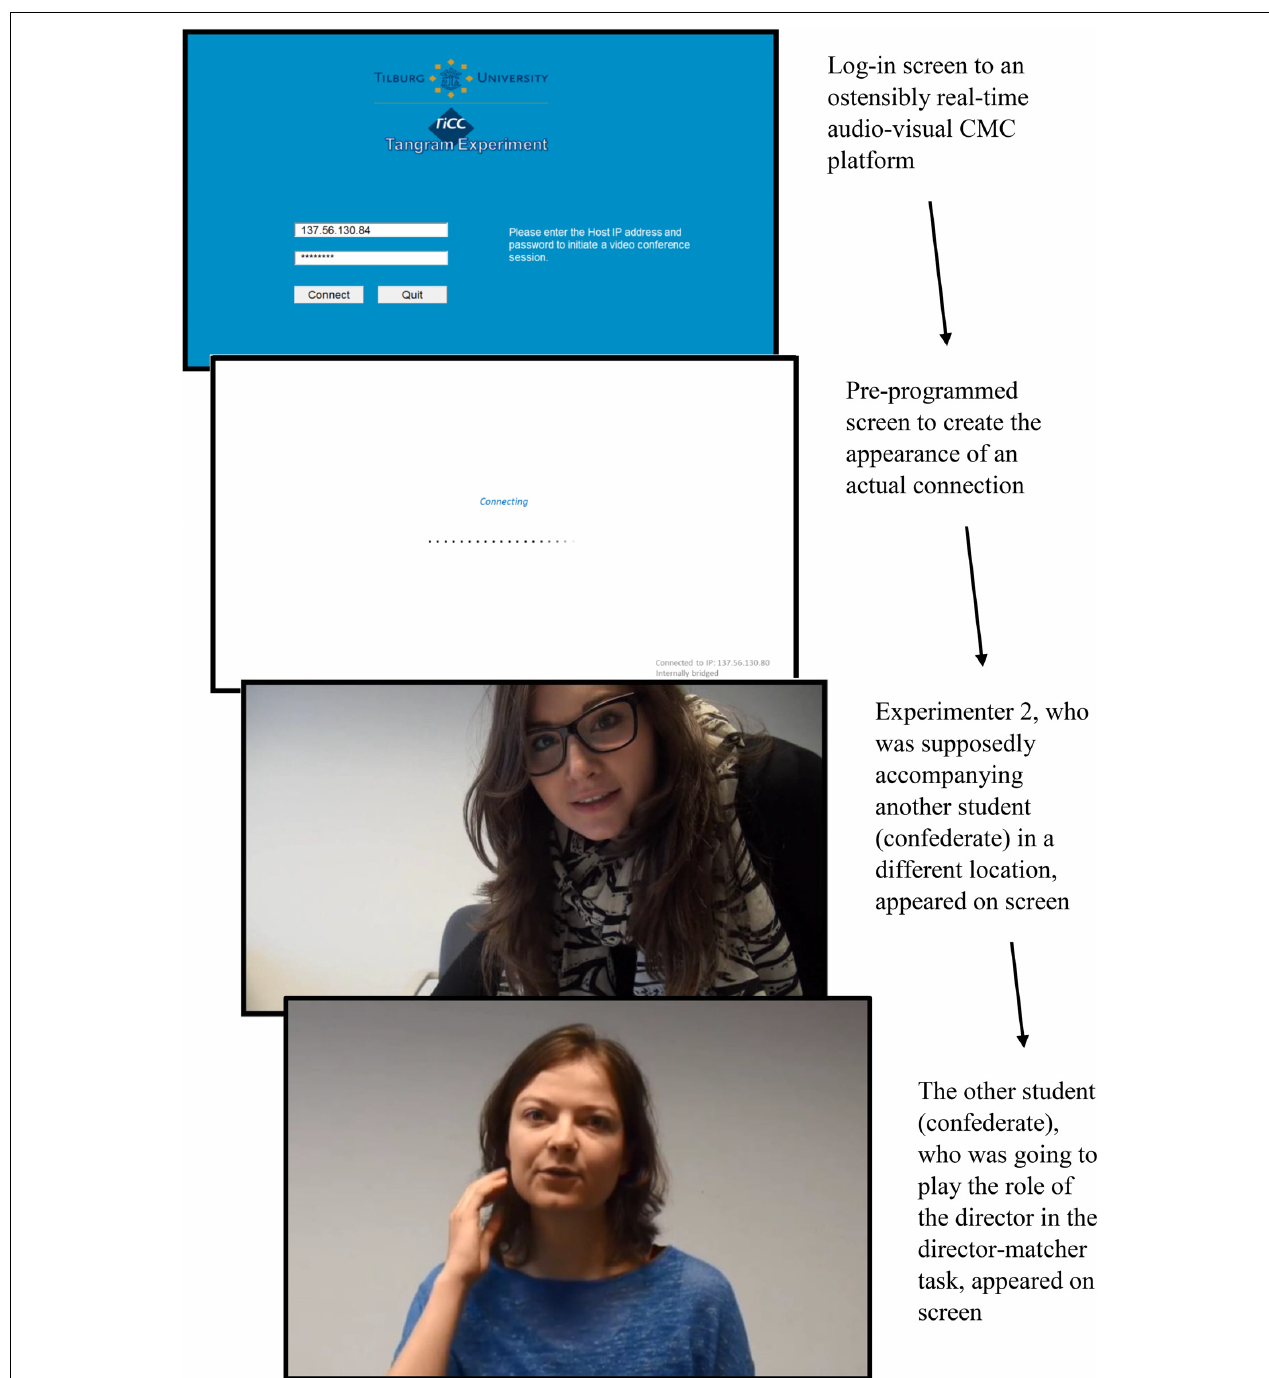
FIGURE 1 | Impression of the CMC set-up, which was based on pre-recorded footage.